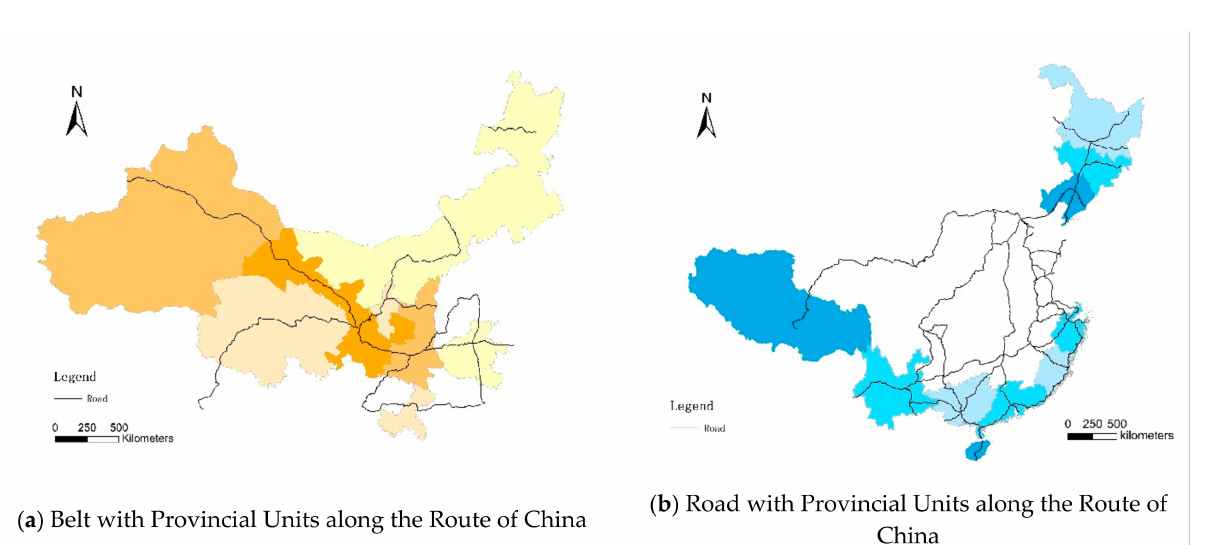
Figure 3. Research